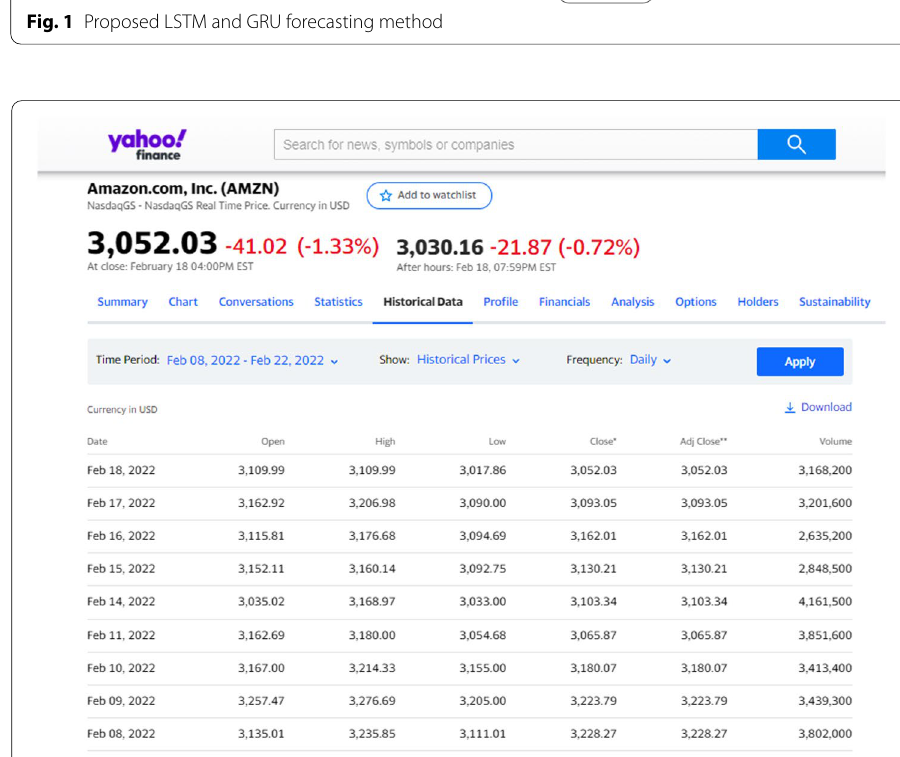
Fig. 2 An example of AMZN stock price time series data for two